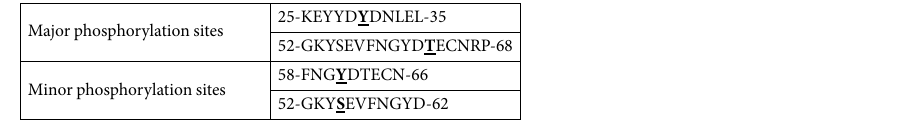
Table 3. The structure was refined to R work /R free = 0.192/0.231 at a resolution of 3.0 Å. Clear electron density was visible for all three molecules (named A, B, C) present in the asymmetric unit (Fig. S1A), allowing unequivocal assignement for of all main chain and a majority of side chain atoms for the polypeptide chain up to residue 328. Residues 329–335 at the C-terminal end of the protein are disordered. The structures of all three monomers were tightly restrained during refinement, resulting in r.m.s. deviations values for their main chain atoms between 0.21 Å and 0.24 Å after superposition (for a total of 316 α -carbon atoms) 24 . A structure-based alignement of the sequences of Pf CK2, Pv CK2 and hCK2 is presented in Fig. 3. Analysis of crystal contacts reveals interfaces between the three monomers extending over an area of approxi- mately 700 Å 2 . Residues brought in extensive intermolecular contact originate from the C-lobe of molecule C and the N terminal arm preceeding the N-Lobe of molecule A. Interestingly, some crystal contacts involve residues from the P-loop, and phosphorylation site around Thr 63 whose structure might be affected by crystal packing forces.